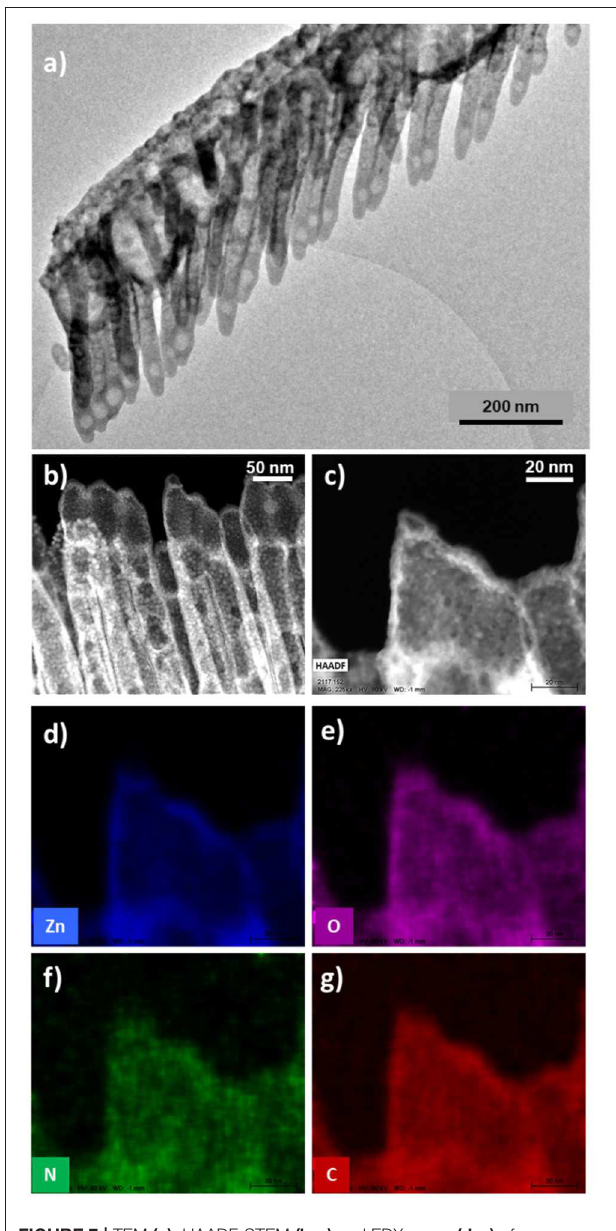
FIGURE 7 | TEM (a) , HAADF-STEM (b-c) and EDX-maps (d-g) of ONWs@ZnPc RPAVD-O 2